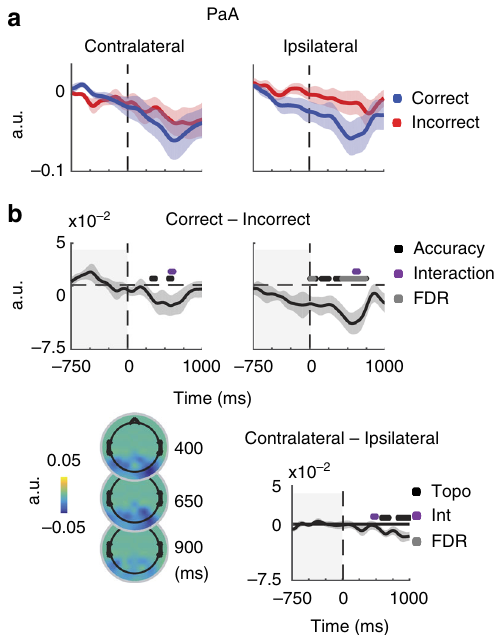
Fig. 5 Shifts in instantaneous frequency predict alpha amplitude. a On a trial-by-trial and timepoint-by-timepoint basis, instantaneous frequency was used to generate predicted alpha amplitudes (PaA). PaA was baselined to the same interval used for alpha amplitude ( − 1000: − 750 pre-target). Shaded areas indicate ± 1 SEM within subjects for correct (blue) and incorrect (red) trials. Reported results are averaged over the same groups of contralateral and Ipsilateral electrodes previously reported. b Correct — Incorrect differences are plotted for Contralateral and Ipsilateral electrodes. For illustration, topoplots indicate Correct — Incorrect topographies averaged over 100 ms bins centered on 400, 650, and 900 s after stimulus onset. All dots indicate signi fi cance from zero, evaluated by comparing the obtained t -value with a null distribution of t -values computed by shuf fl ing the condition labels 10,000 times. This analysis was done on a timepoint- by-timepoint basis from stimulus onset to + 1000 ms, as indicated by the non-shaded areas (see Methods). Main effects of accuracy indicated in blue and yellow in contralateral and ipsilateral electrodes, red indicates a main effect of topography. Gray dots indicate signi fi cance after FDR correction at P <